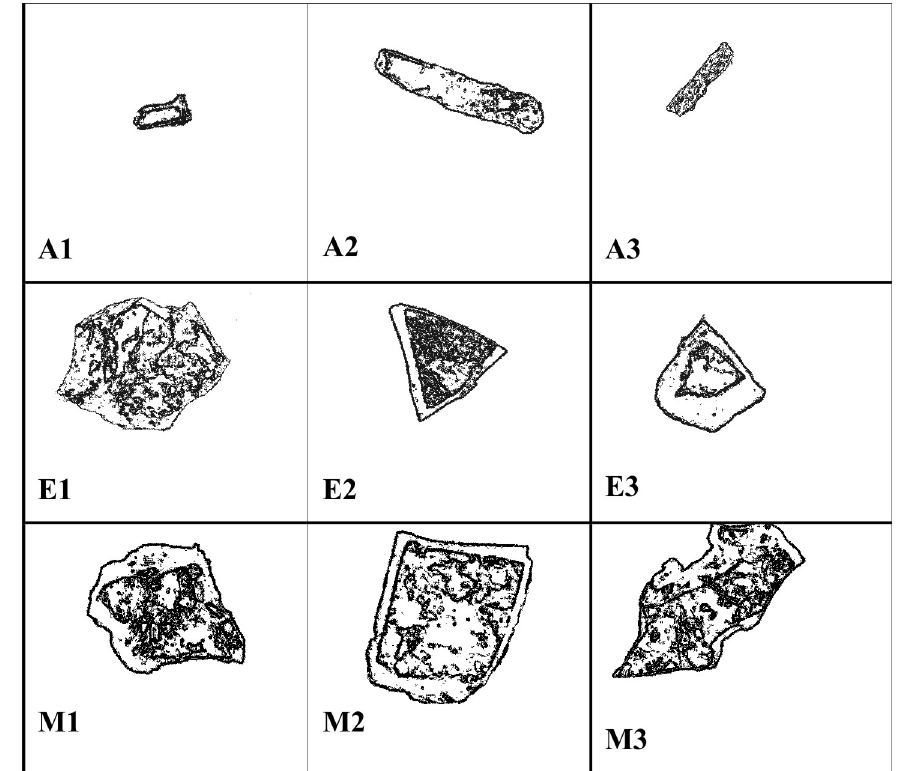
FIGURE 1 - Microphotographs taken with 10x objective, converted to binary format for measurement. Letters correspond to